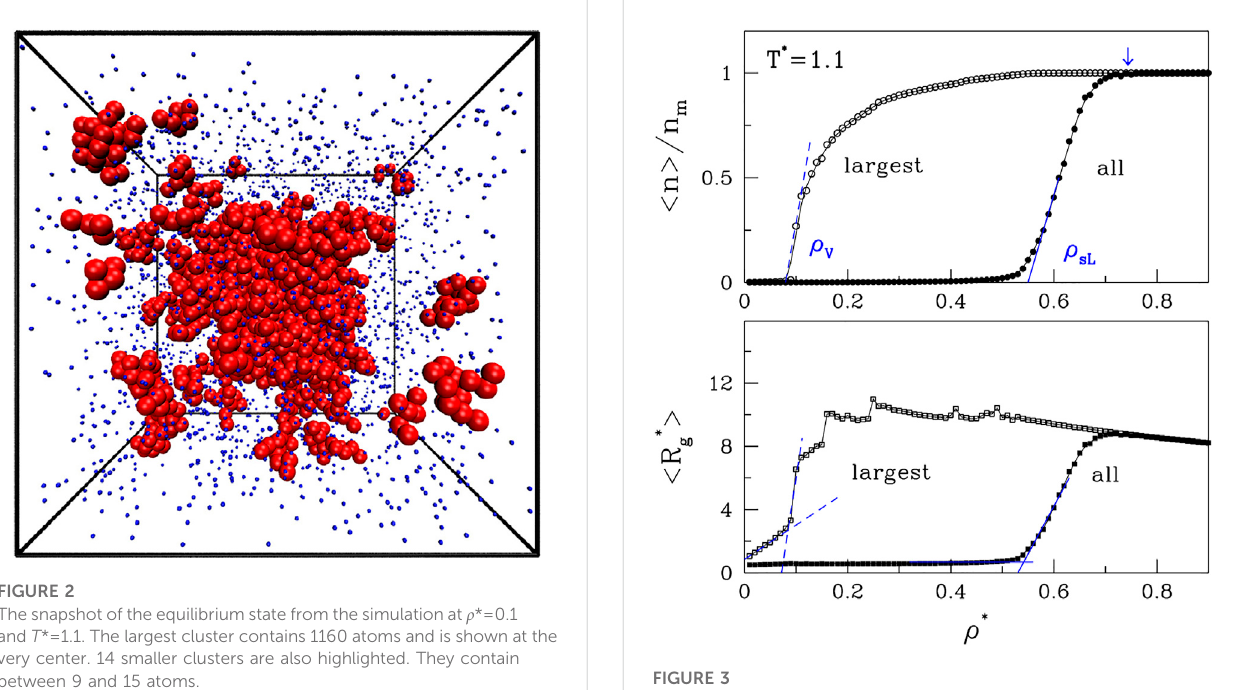
The panels, correspondingly, show the plots of 〈 n 〉 and 〈 R g 〉 vs. ρ * for T *=1.1.Thedatapointsobtainedbyconsideringallclustersareshown by the solid symbols. The open symbols correspond to the largest clusters. It would be tempting to identify the density point at which the lines 〈 n lar 〉 and 〈 n 〉 merge (the arrow at the top) as corresponding to ρ L .However,thelocationofthispointpracticallydoesnotdependon T